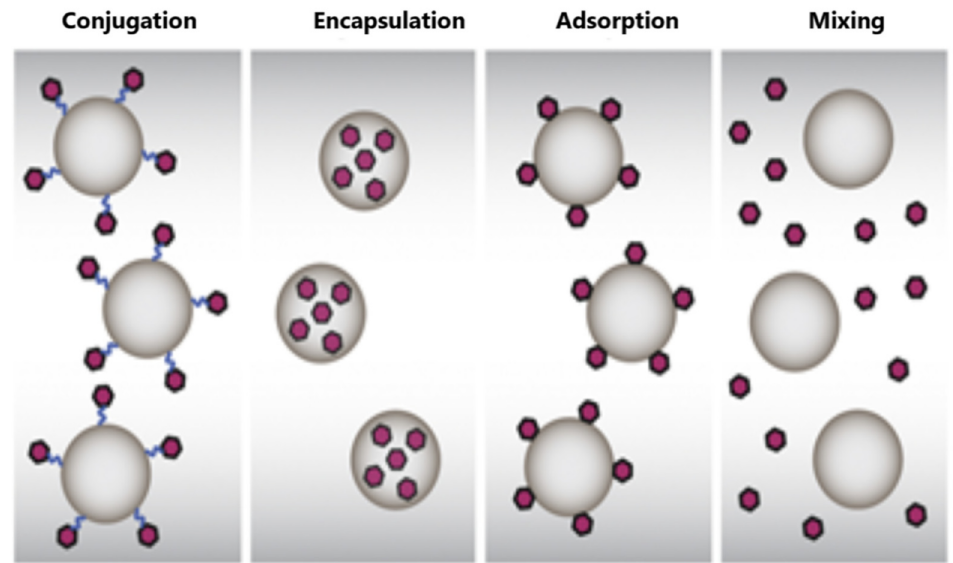
Figure 1. Interaction of nanoparticles with an antigen of interest. Formulation of nanoparticle and antigen of interest can be implemented through attachment (e.g., conjugation, encapsulation, or adsorption) or simple mixing. (Adapted from